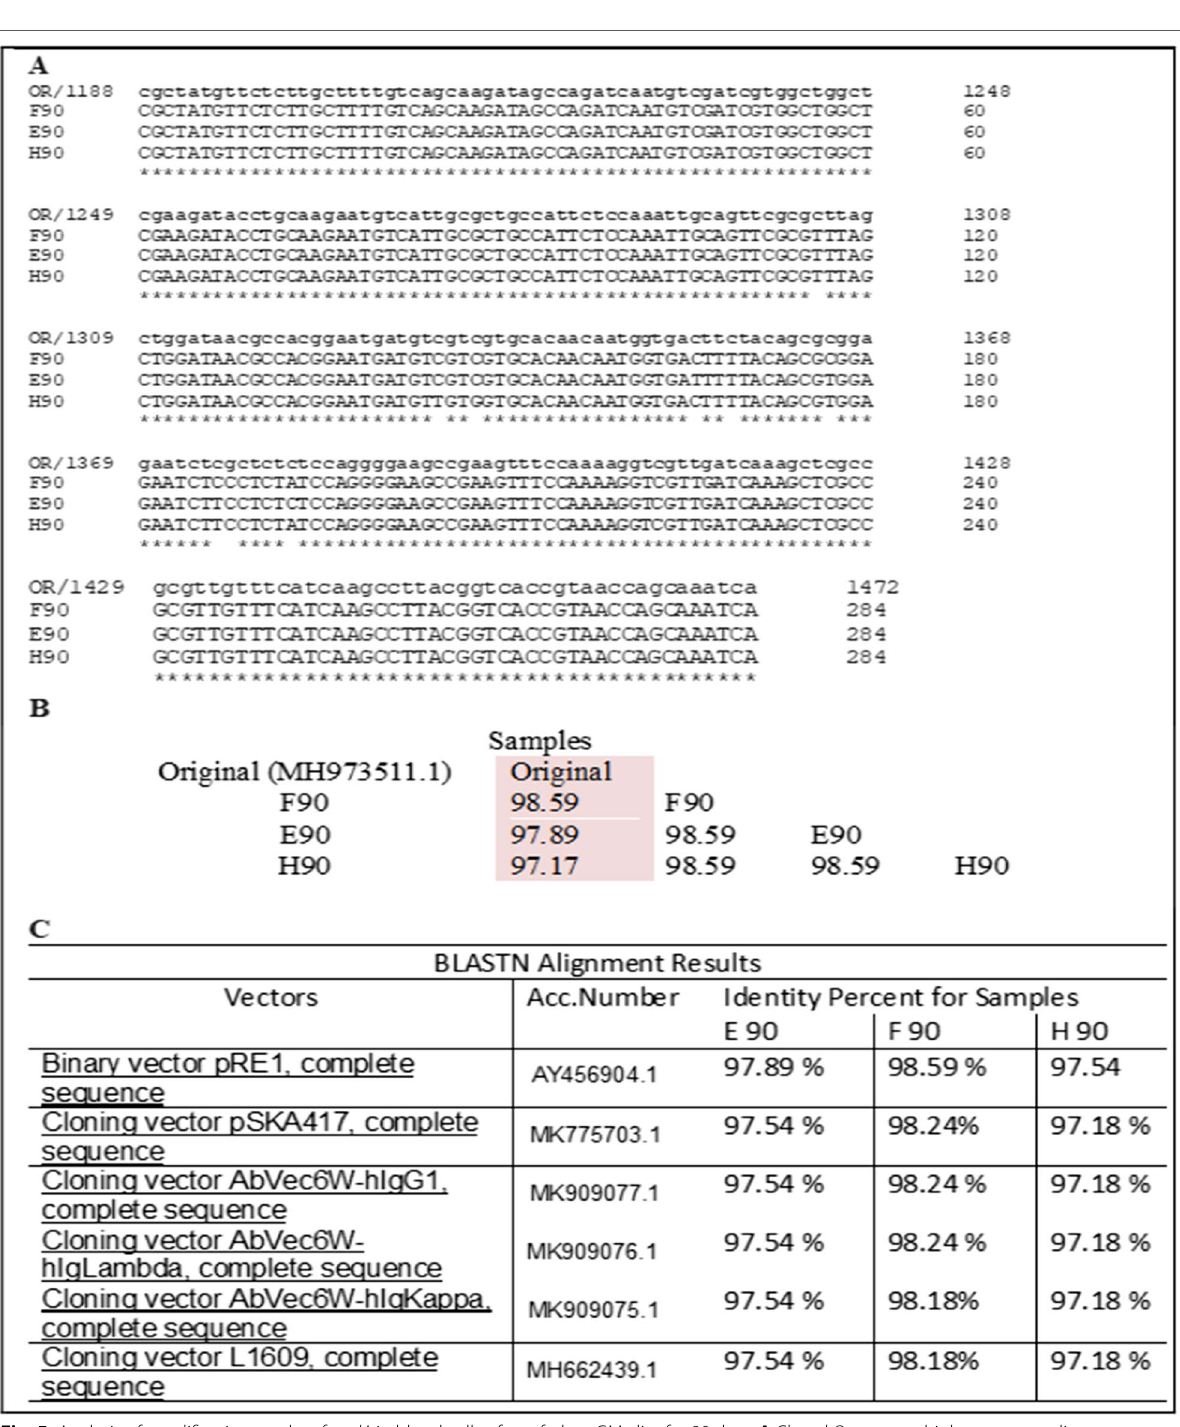
Fig. 5 Analysis of amplification results of aadA in blood cells of rats fed on GM‑diet for 90 days. A Clustal Omega multiple sequence alignment of the internal nucleotide sequences of aadA (284 bp) in a number of blood samples along with the corresponding segment from the reference sequence (MH973511.1). B Percent Identity Matrix created by Clustal2.1 for the internal nucleotide sequences of the PCR amplicon (F90, E90, and H90) obtained from the amplification of primers for aadA gene. Original is the reference sequence of the corresponding segment of aadA (MH973511.1). C Variable similarities percentages of number of vectors that produced significant alignment with aadA